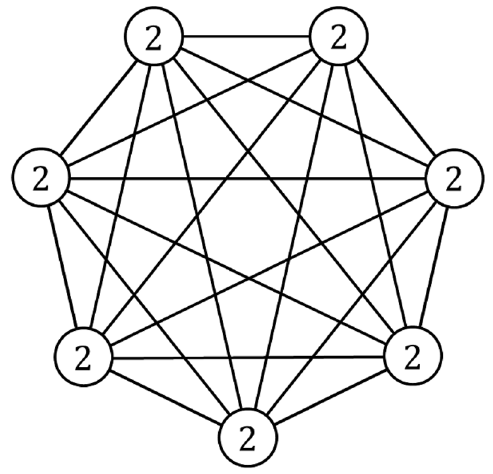
Figure 2 . Triality frame